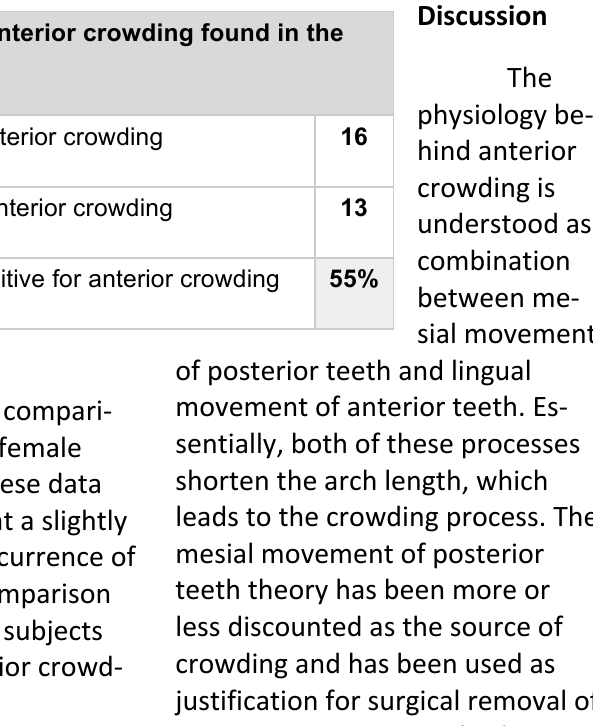
Table 2. Comparison of crowding by sex.